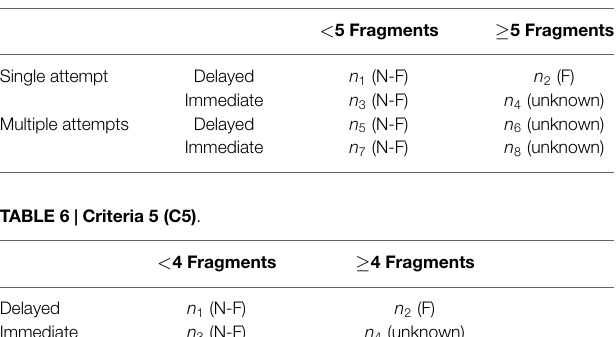
TABLE 5 | Criteria 4 (C4) .